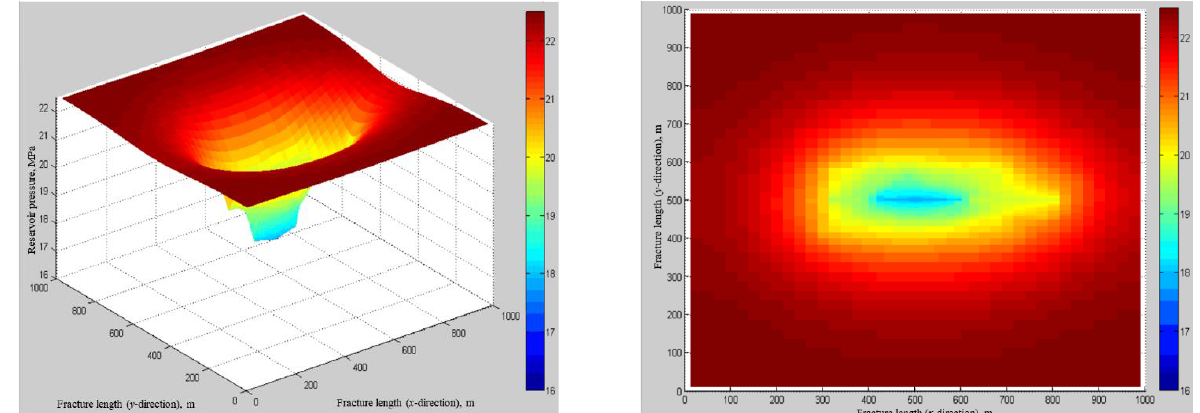
Figure 13. Reservoir pressure distribution at the time of one year.